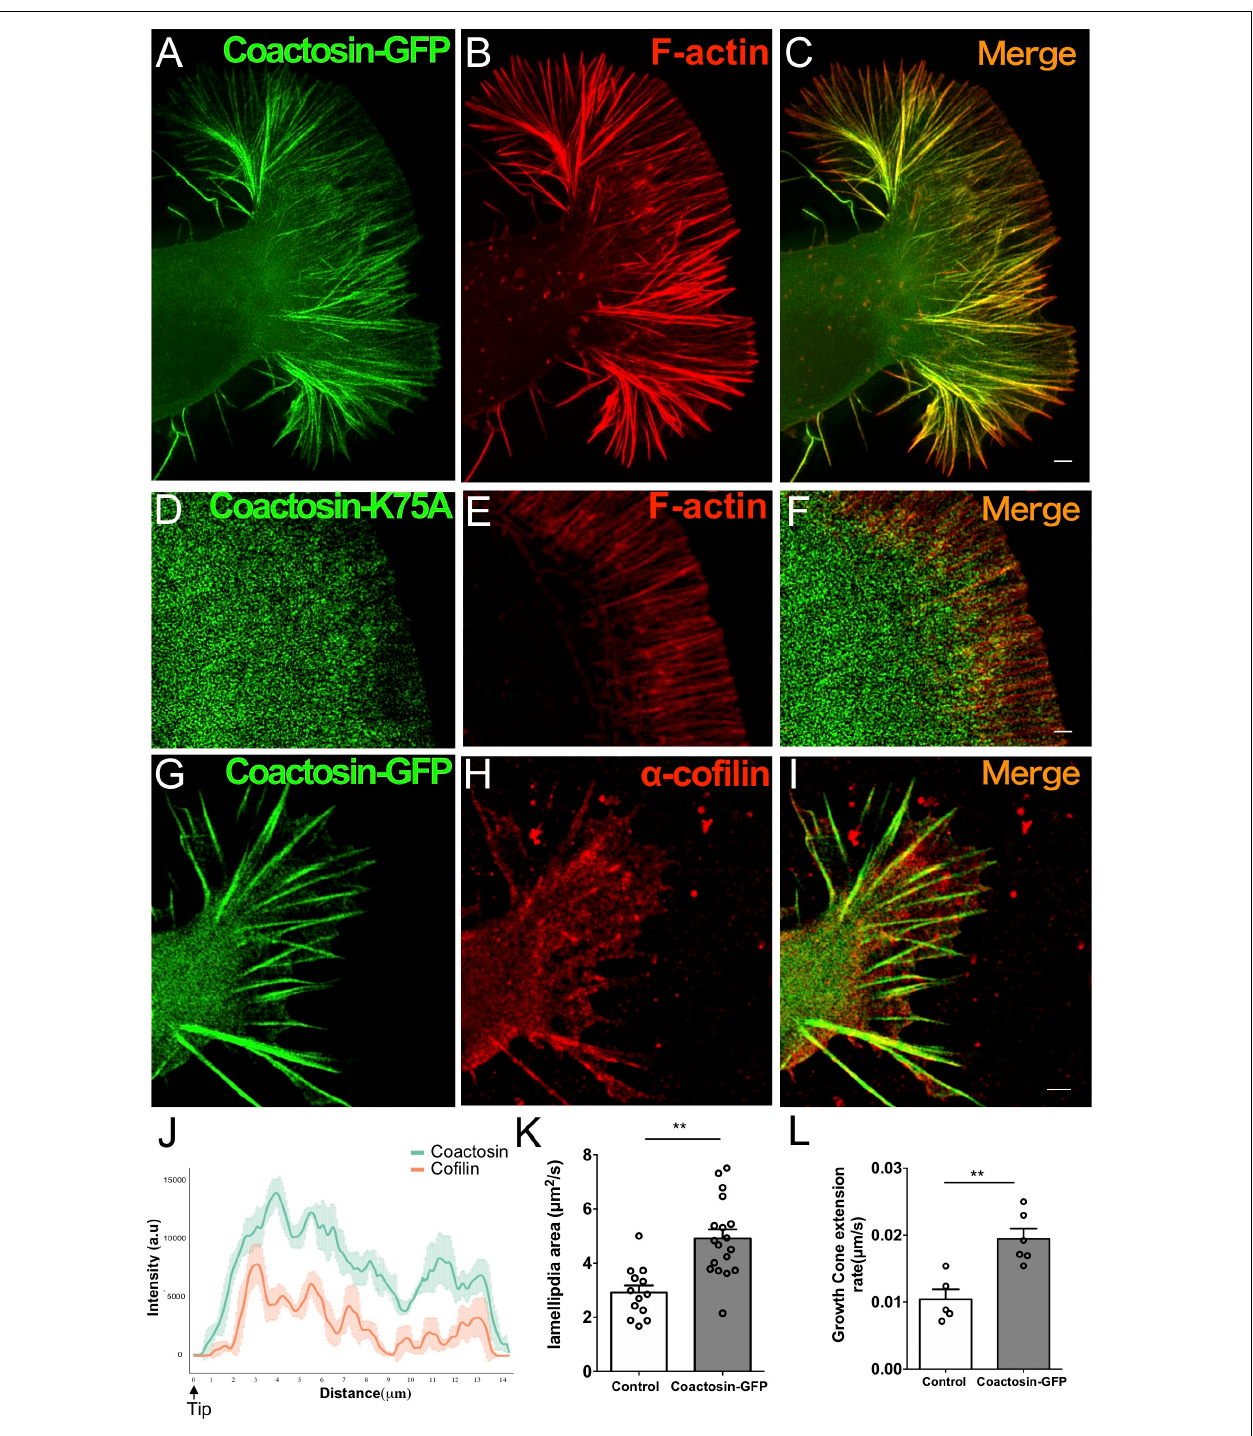
FIGURE 4 | Association of coactosin with F-actin extends the growth cones of NG108-15 cells. (A–C) Co-localization of GFP-coactosin ( green ) and F-actin (rhodamine-phalloidin, red ) in SIM images of a growth cone. (D–F) Distribution of mutated coactosin (K75A) in a growth cone. Coactosin K75A ( green ) that cannot bind F-actin did not accumulate on F-actin ( red ). (G–I) Distribution of cofilin with coactosin overexpression in a growth cone. Note that cofilin accumulation is weak at the tip of filopodia. (J) Quantitative distribution of the fluorescence intensities of GFP-coactosin ( green ) and cofilin ( red ) ( n = 22 for each, means ± SEM). (K) The area change of lamellipodia shows rapid expansion with coactosin overexpression than control (also see Movies, 13–18 lamellipodium, ** p = 0.0025, Mann–Whitney U test). (L) Increased rate of growth cone extension with coactosin overexpression compared with the control (5–6 cells, ** p = 0.0031, Mann–Whitney U test). Scale bars, 1 µ